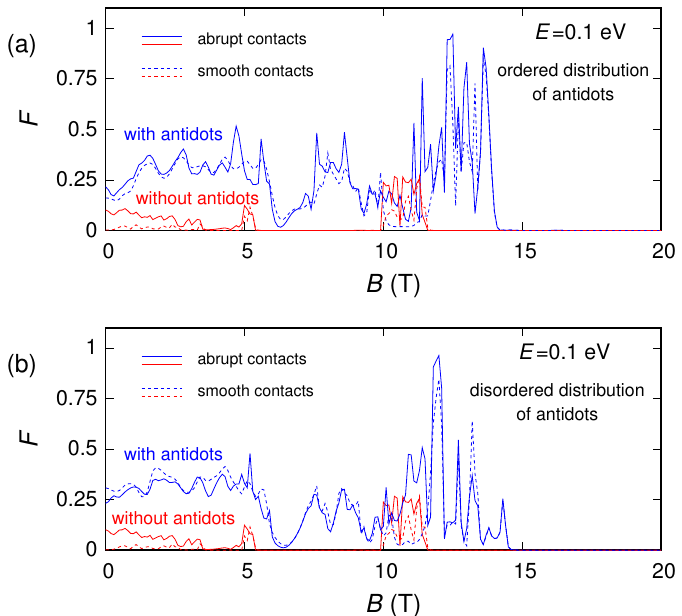
Figure 8. Fano factor of the graphene ribbon as a function of the orthogonal magnetic field, obtained for E = 0.1 eV in the presence of an ordered (panel ( a )) and a disordered (panel ( b )) distribution of antidots, compared with the Fano factor of the ribbon without